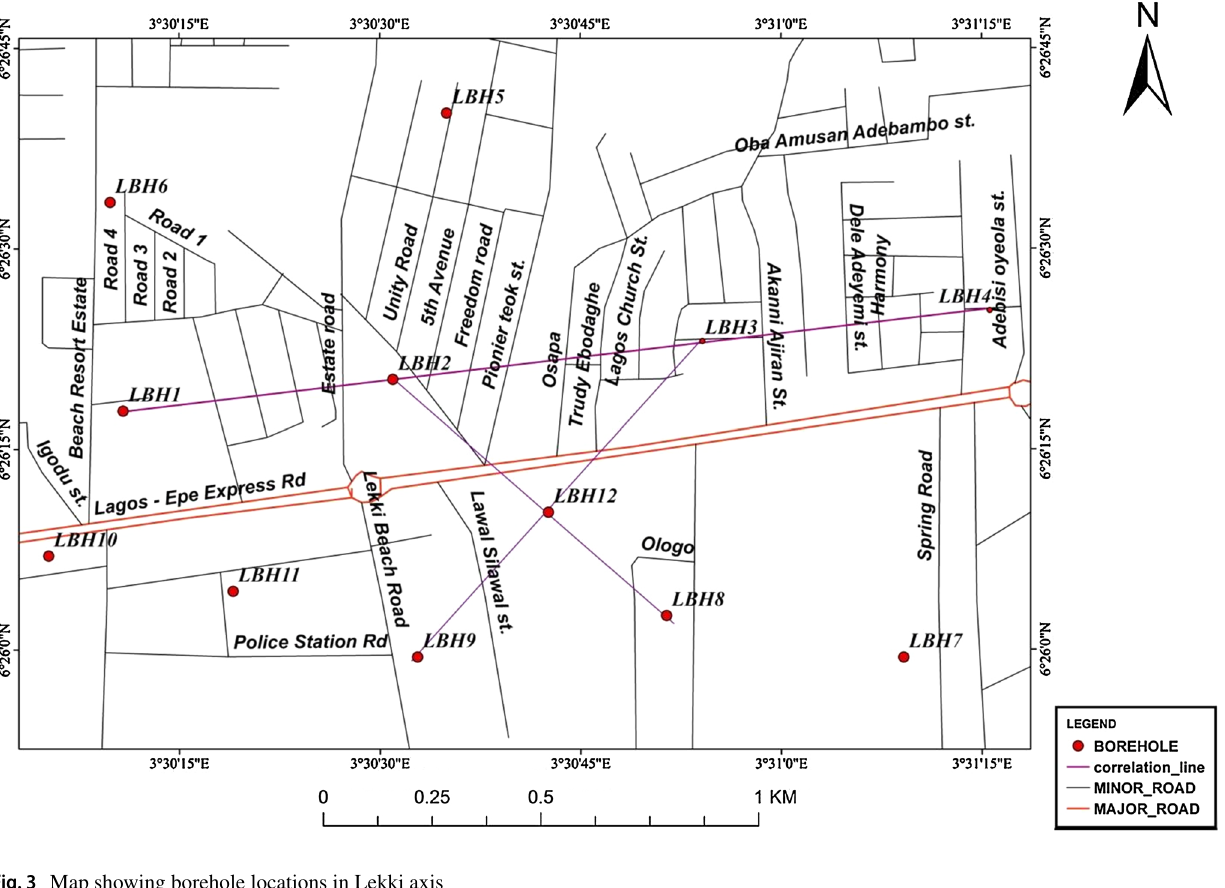
Table 1 Physical parameters of water in typical sedimentary environment (modified after Ibrahim